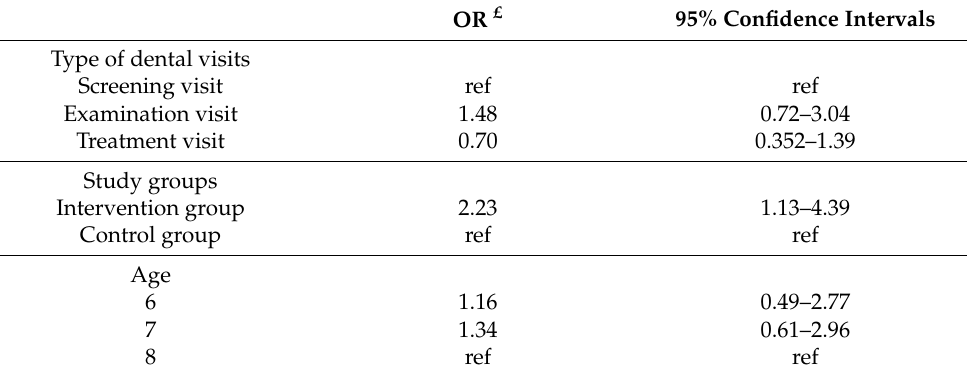
Table 10. Multivariate mixed-effects logistic regression model analysis for factors affecting patient anxiety with